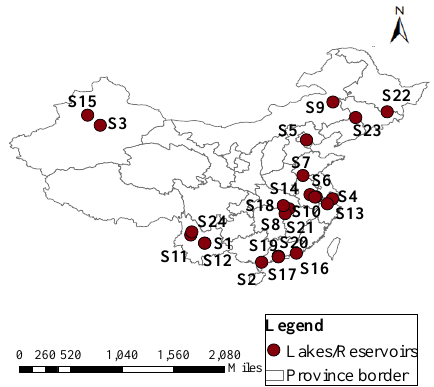
Figure 1. Locations of 24 typical lakes/reservoirs in China.